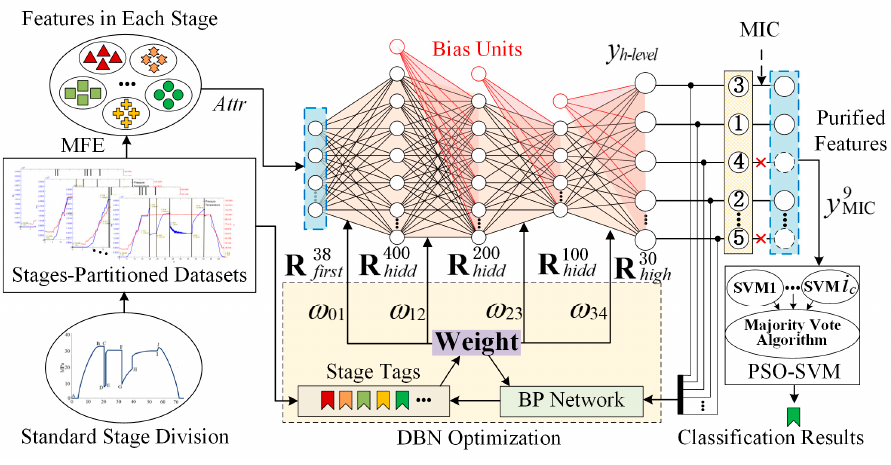
Figure 7. MFE-DMIC Figure 7. MFE ‐ DMIC workflow.